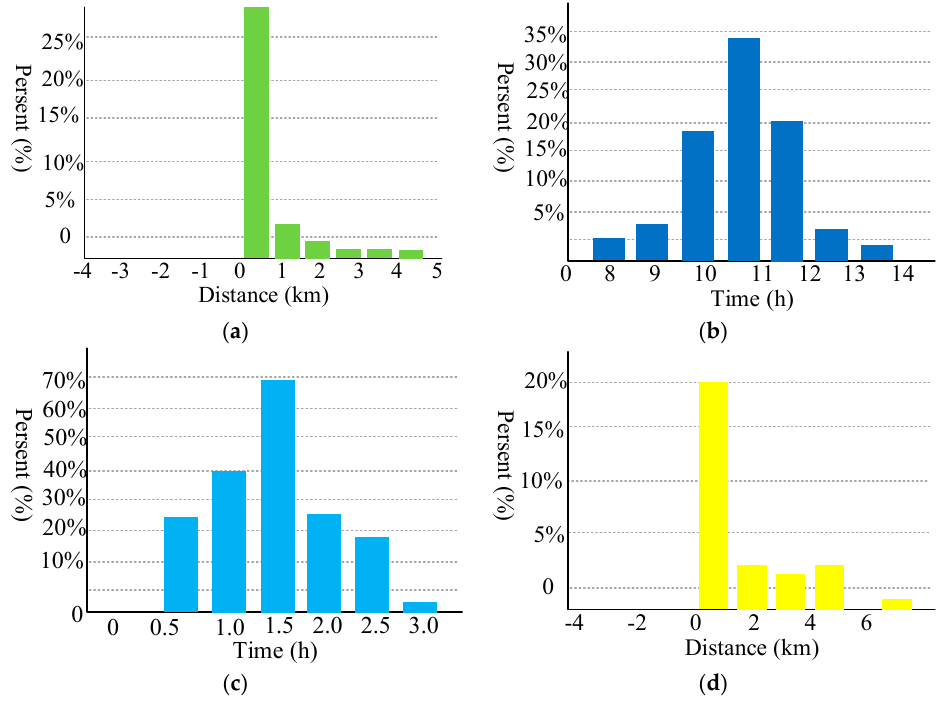
Figure 5. The probability histograms of behavior characteristics using taxi-driver shift samples: ( a ) interval distance ( f 1 ), ( b ) interval time ( f 2 ), ( c ) transition time ( f 3 ), and ( d ) average no-load distance ( f 4 ).